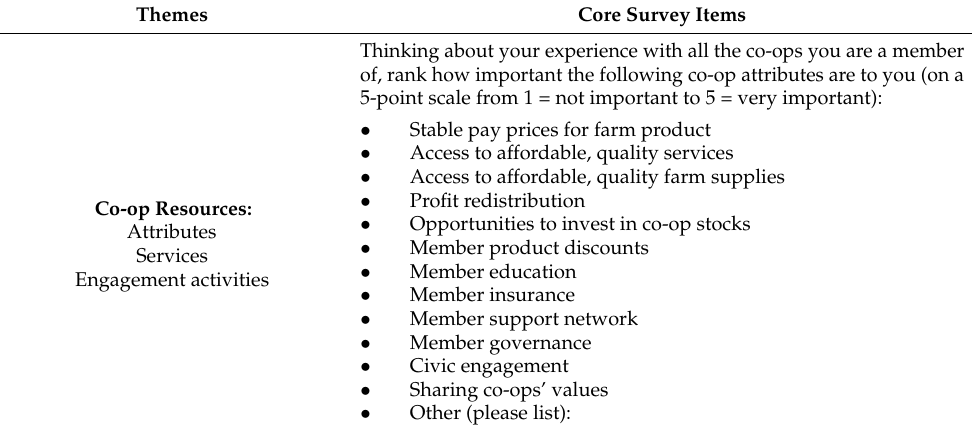
Table 1. Core survey items organized by themes example (see Appendix A for full